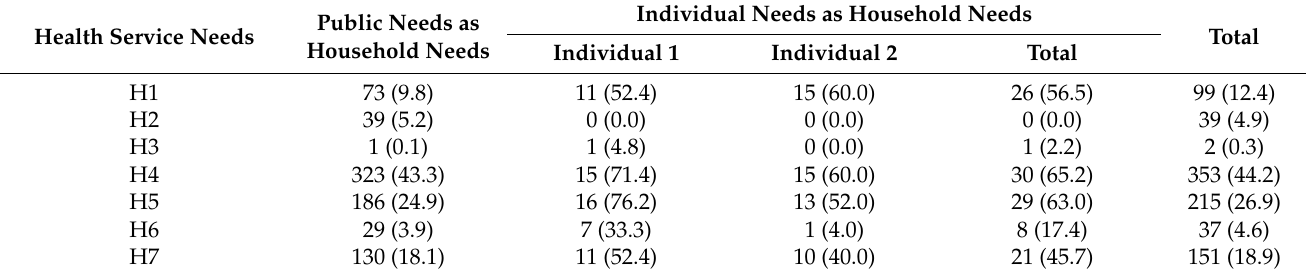
Table 3. Health service needs in empty nest households ( n , %).